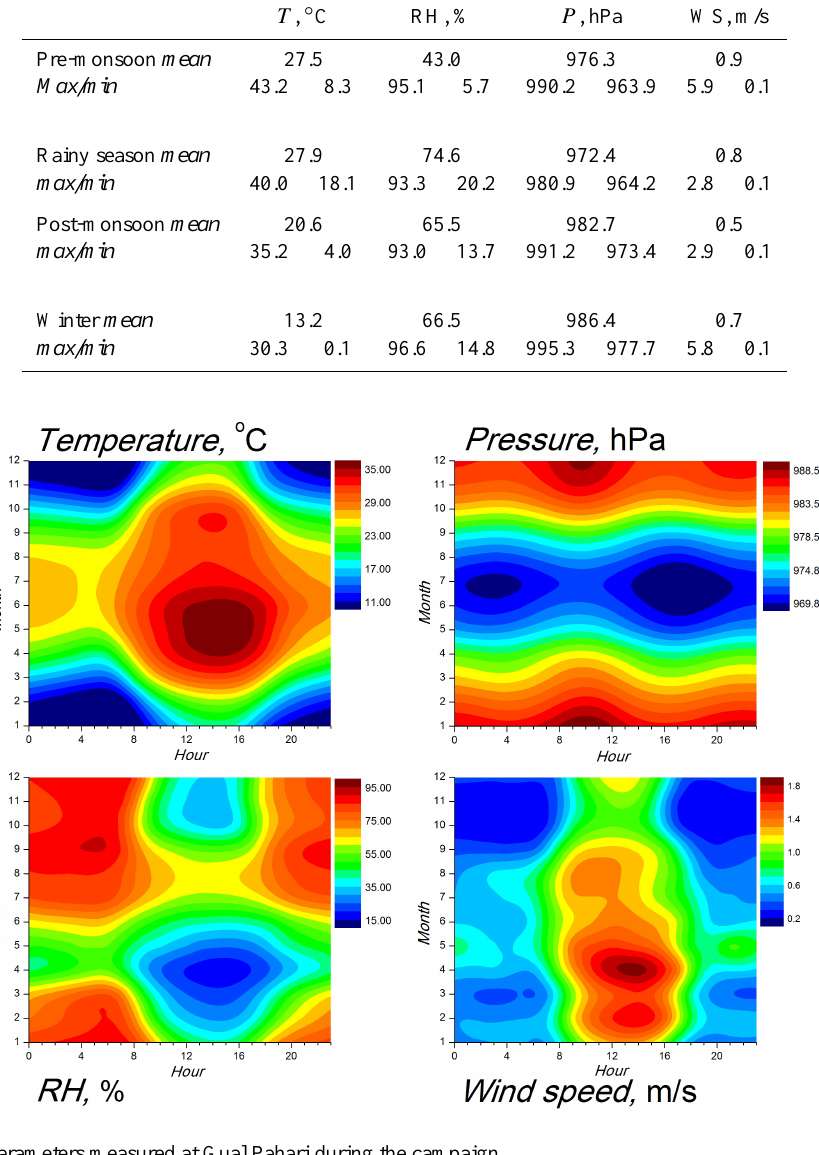
Fig. 2. Meteorological parameters measured at Gual Pahari during the campaign. The average temperatures were highest during the rainy season, but the maximum temperature was found during the pre-monsoon season. This is due to much higher diurnal tem- perature gradient during the pre-monsoon. During the winter, the coldest nights reached zero degrees ◦ C. The highest av- erage relative humidity took place during the rainy season, while the maximum RH’s were observed during the winter, due to the very cold nights. The highest difference between the maximum and minimum RH took place during the pre- monsoon season due to high diurnal variation of the temper-